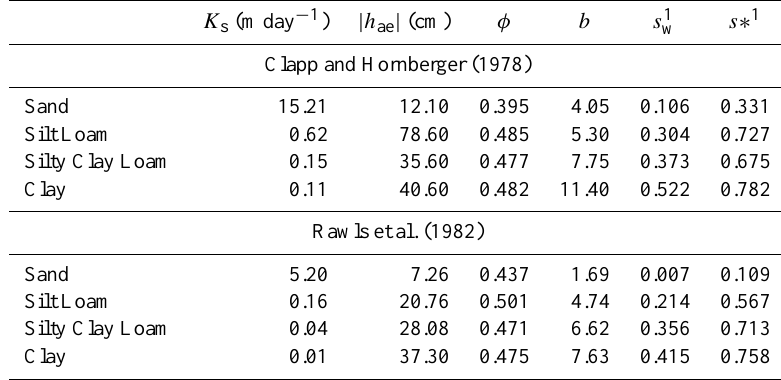
Table 1. Soil hydraulic parameters used in the model simulations (see Sect. 2 for variable